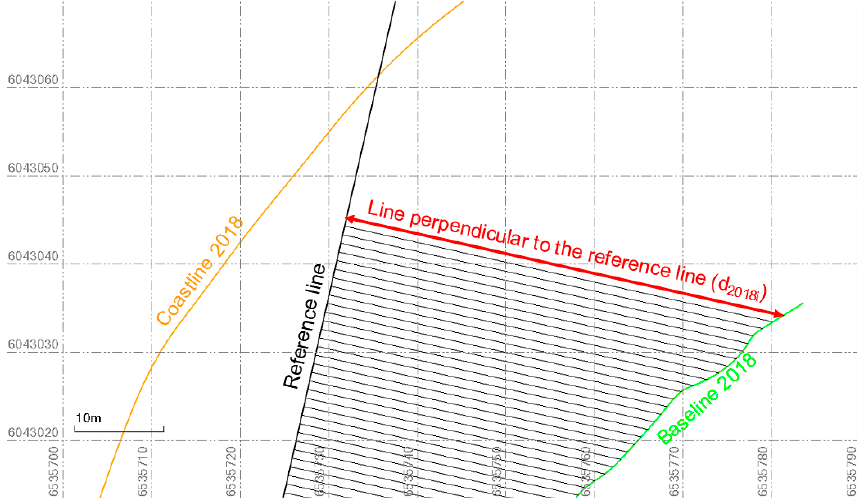
Figure 7. Graphical method to determine the distance between the reference line and the baseline.